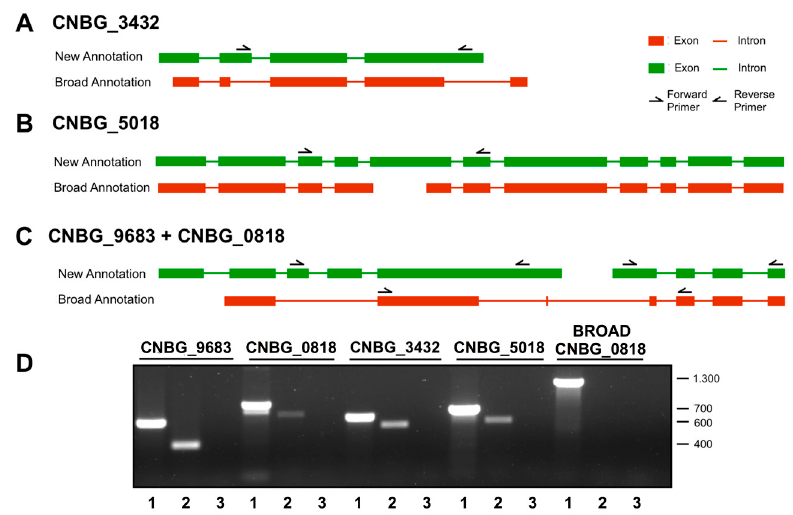
Figure 2. Experimental confirmation of the gene models. ( A – C ) Four genes were selected to confirm the changes in annotation provided by the RNA-Seq validation. Additionally, a primer pair designed to specifically amplify the predicted Broad annotation of the gene CNBG_0818 was design to confirm that it is in fact two genes. ( D ) The selected genes were confirmed by RT-PCR. For each gene, one genomic DNA (1) template, one cDNA template (2), and a negative control (3) were evaluated. All but Broad CNBG_0818 were amplified, indicating that the new annotation was correct. Values on the left refer to the band sizes (bp) of the molecular size marker. The green/red rectangles represent the exons, and the green/red lines between them are the introns; according the new and old (Broad) annotations, respectively.